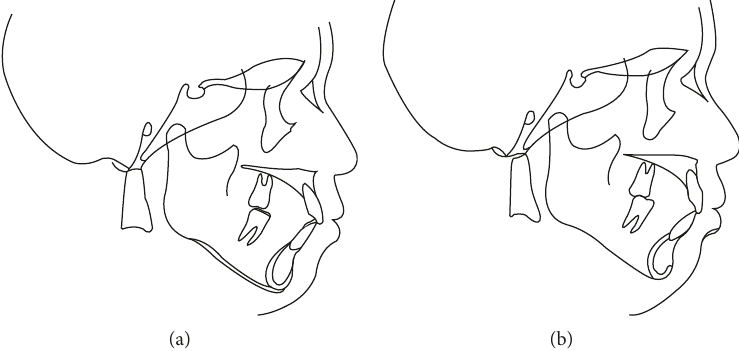
Figure 13: A superimposed cephalometric tracing is shown. (a) From pre-orthodontic treatment to post-orthodontic treatment; (b) from post-orthodontic treatment to postretention.